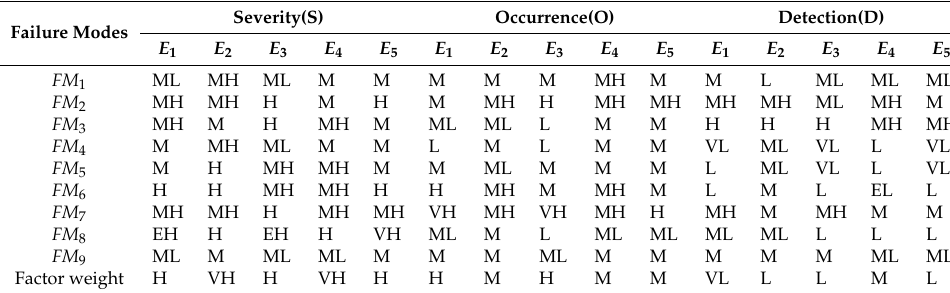
Table 3. Evaluation information on the nine failure modes provided by the FMEA team